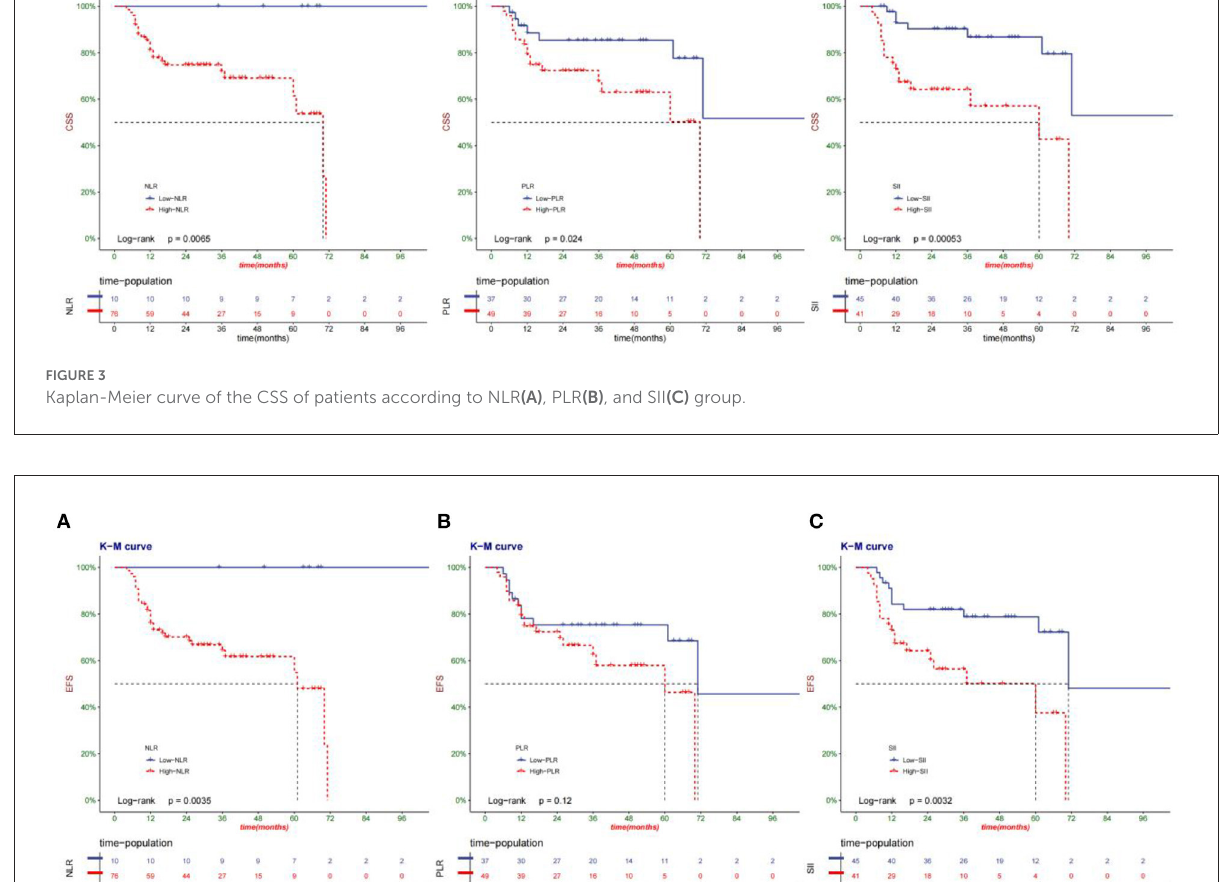
ROC curve analysis. With the extension of time, AUC gradually